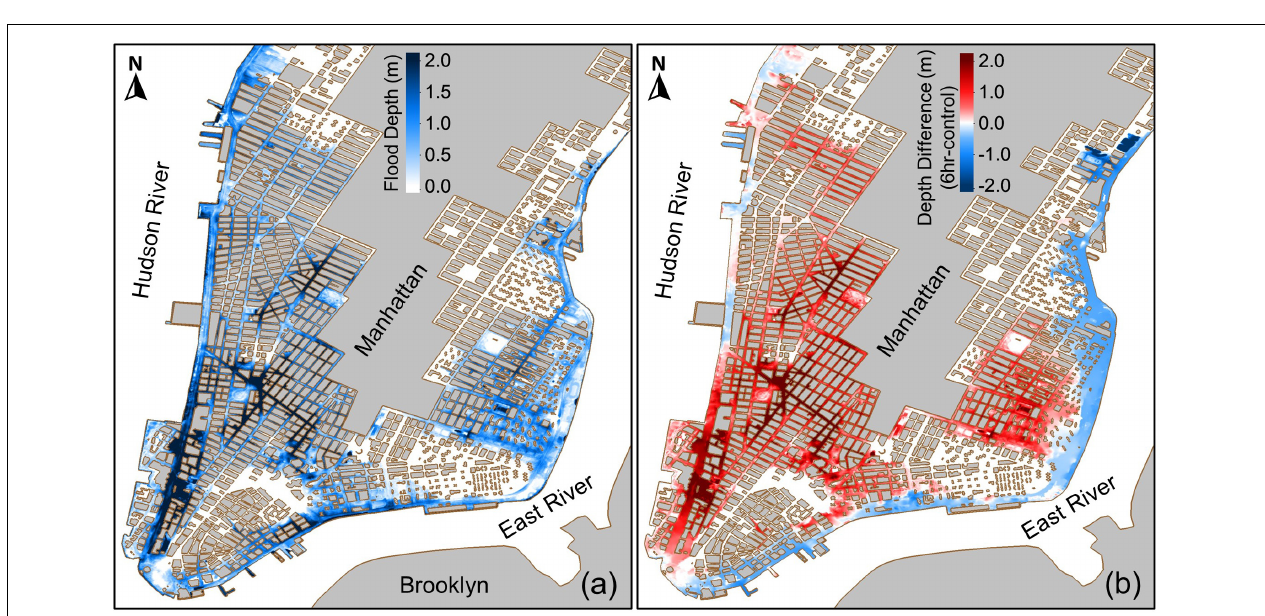
FIGURE 9 | (A) Flooded area (solid circles represent the area with a flood depth greater than 1 m; hollow circles represent the total flooded area). Area represents the area of open spaces and excludes the area occupied by buildings. (B) Temporal maximum flood depth. The central mark on each box indicates the median (of flood depth in flooded computational nodes), the top and bottom edges of each box indicate the 25th and 75th percentiles, and the whiskers extend to the most extreme flood depths.